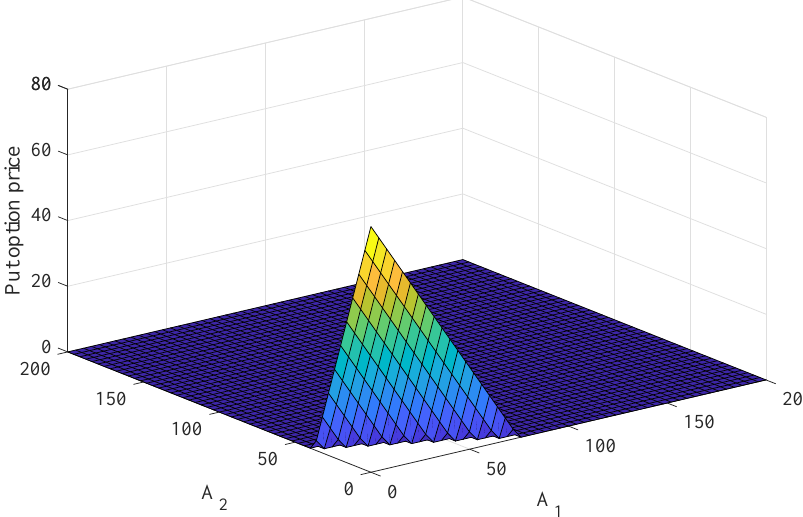
Figure 1. The explicit solution surface plot of the European put option price obtained from the Black–Scholes model with two stock prices, A 1 , A 2 and correlation ρ =